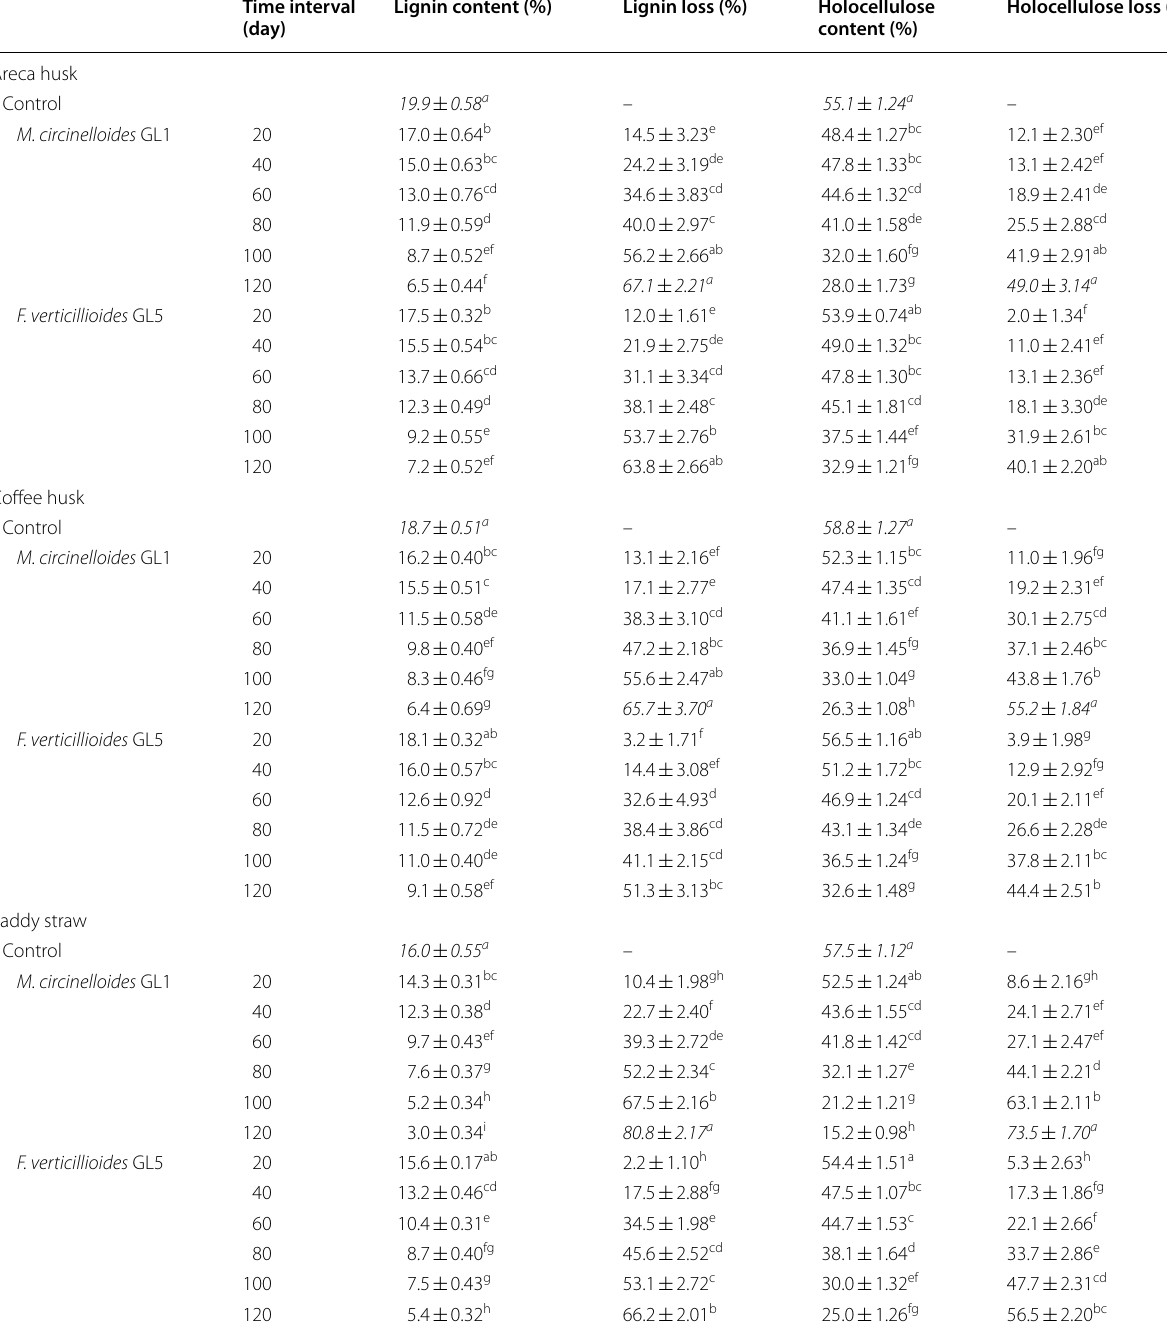
Table 3 Changes in lignocellulose content and loss of solid substrates treated with ligninolytic fungi during solid-state fermentation in different time